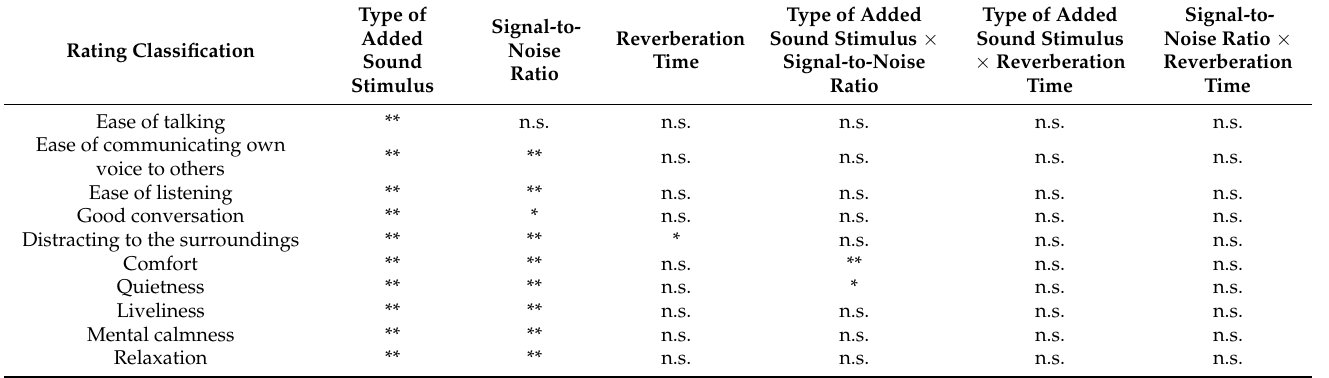
Table 3. Results of the three-way analysis of variance; “n.s.” in the table represents an abbreviation for “no significant